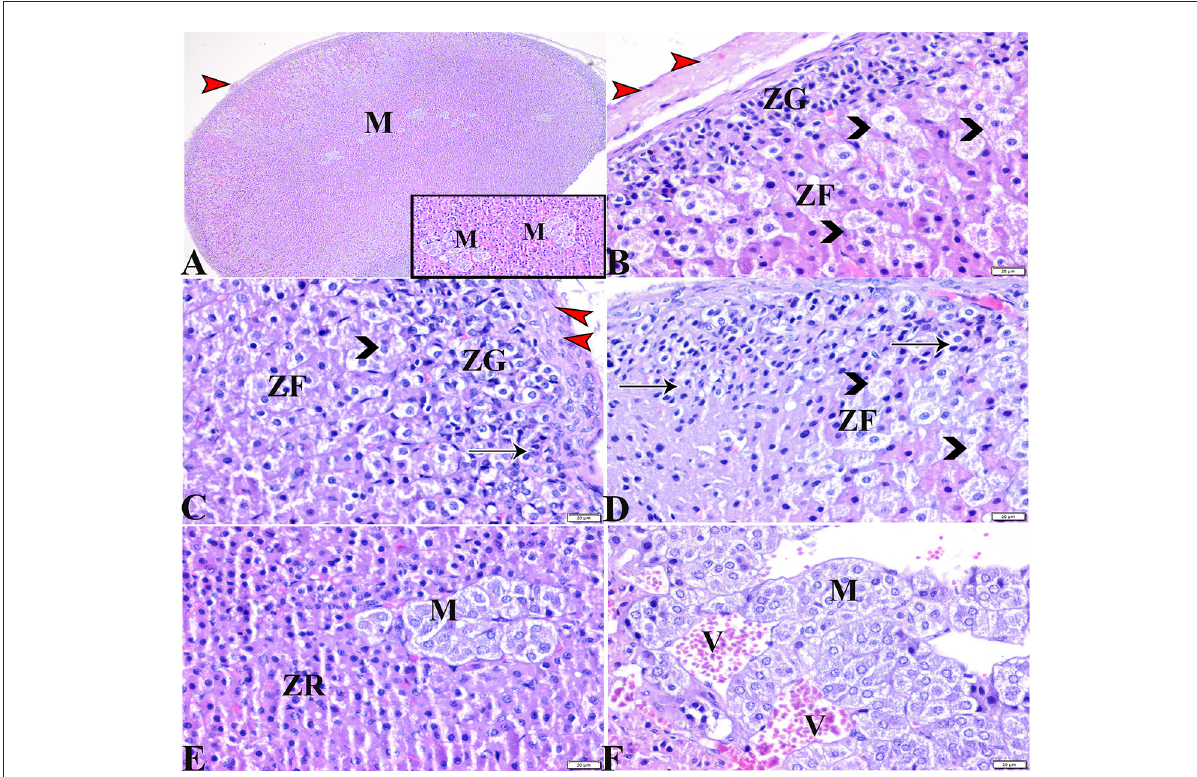
FIGURE4 Photomicrographs of adrenal gland sections from the diabetic STZ group (A–F) showing: (A–C) Thick connective tissue capsules (red arrowheads), distortion in the adrenal cortical structures; Zona granulose (ZG) and Zona fasciculate (ZF), in addition to adrenal medulla (M) [ (A) , selected square]. (B–D) Hyperplasia in the ZG cell layer [ (B,C) , ZG], with pyknotic cellular nuclei [ (C,D) , thin arrows], hyperplasia and vacuolation of the ZF cellular layer, loss of its radial arrangement and some cells contain karyolysis nuclei [ (B–D) , arrowheads]. (E) Distorted ZR cells (ZR). (E,F) Atrophied adrenal medulla with vacuolated chromaffin cells (M). (F) The medullary veins are severely dilated and engorged with blood (V). H&E stain. The bar size is indicated under each